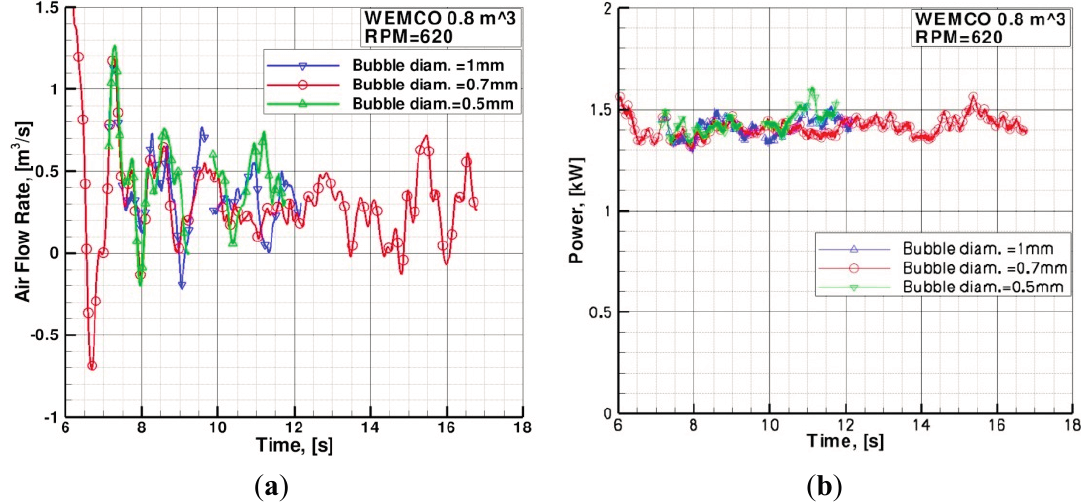
Figure 4. Effects of assumed bubble diameter on airflow rate and power, d b = 0.5, 0.7 and 1.0 mm; ( a ) Variation of air volume flow rate with time; ( b ) Variation of power with